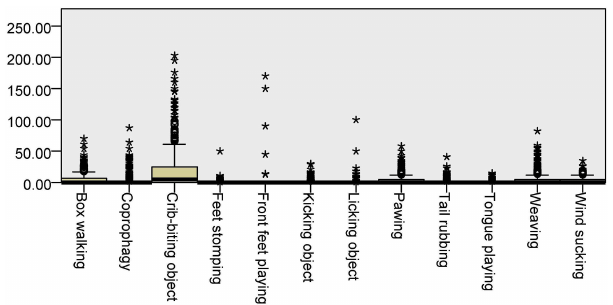
Figure 2. Frequency of abnormal behavior during observations. The data points shown are the results of repeated observations made by the six horses during the study